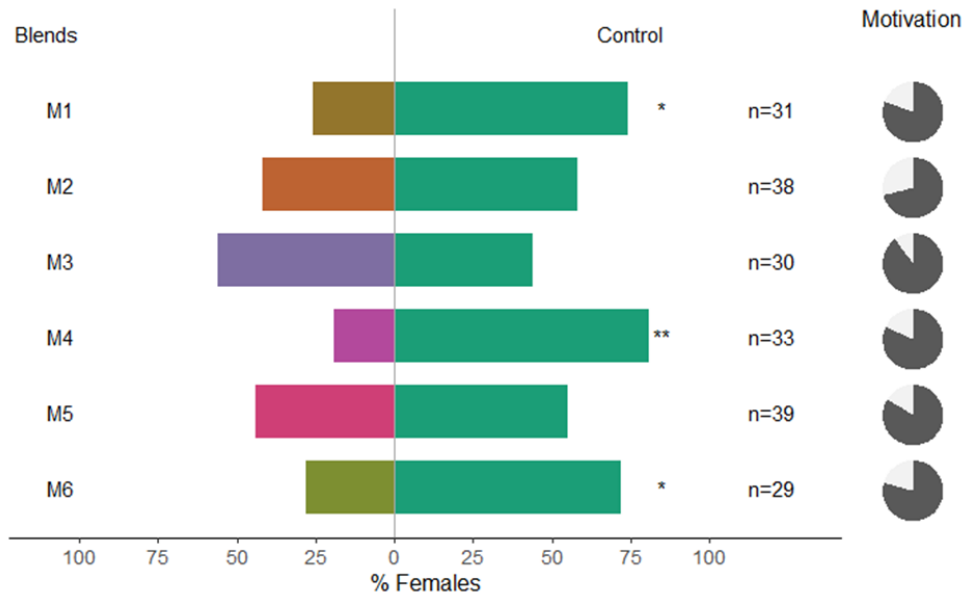
Figure 2. Results of Y-olfactometer-bioassays testing synthetic clove VOCs dissolved in methanol with adults of Cacopsylla pyricola . Pure methano l was used as control. The letter “n” corresponds to the numbers of insects used for the tests. Results are shown as the percentage of psyllids in each arm. Statistically significant differences are indicated with * ( p < 0.05). The percentage of psyllids that made a choice (dark gray) or not (light gray) is presented as pie charts on the right.